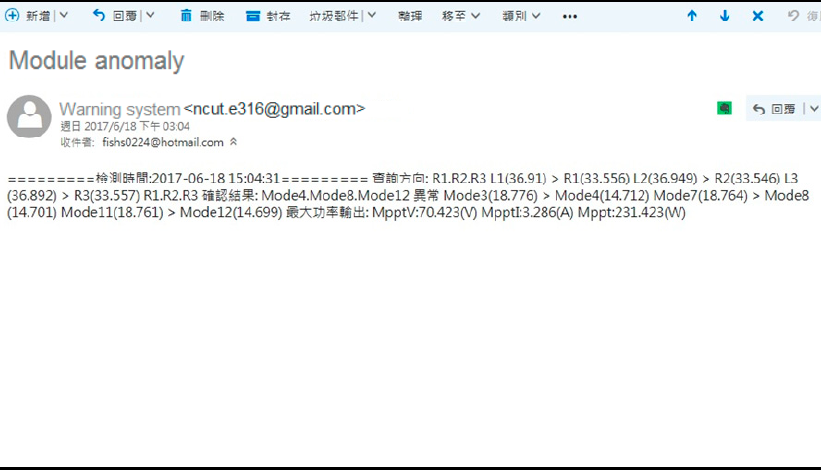
Figure 9. Automatic warning message.